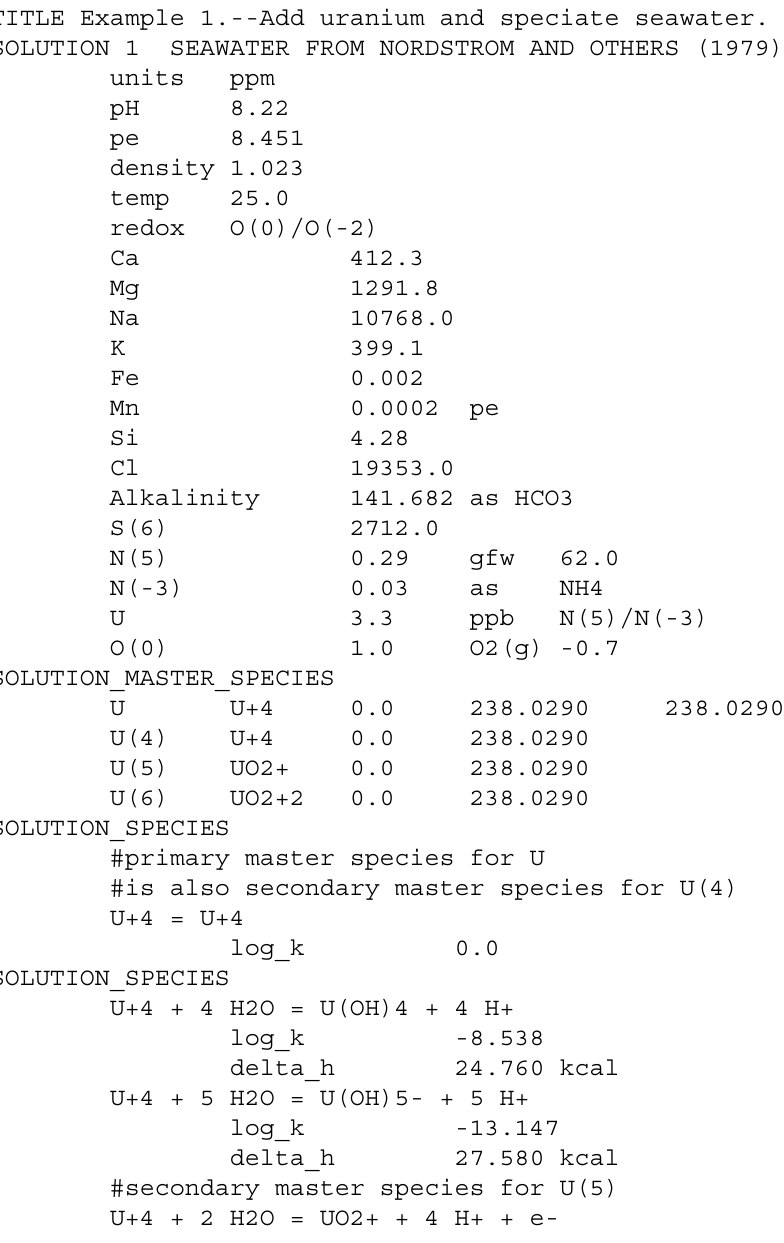
Table 10. Input file for example 1. TITLE Example 1.--Add uranium and speciate